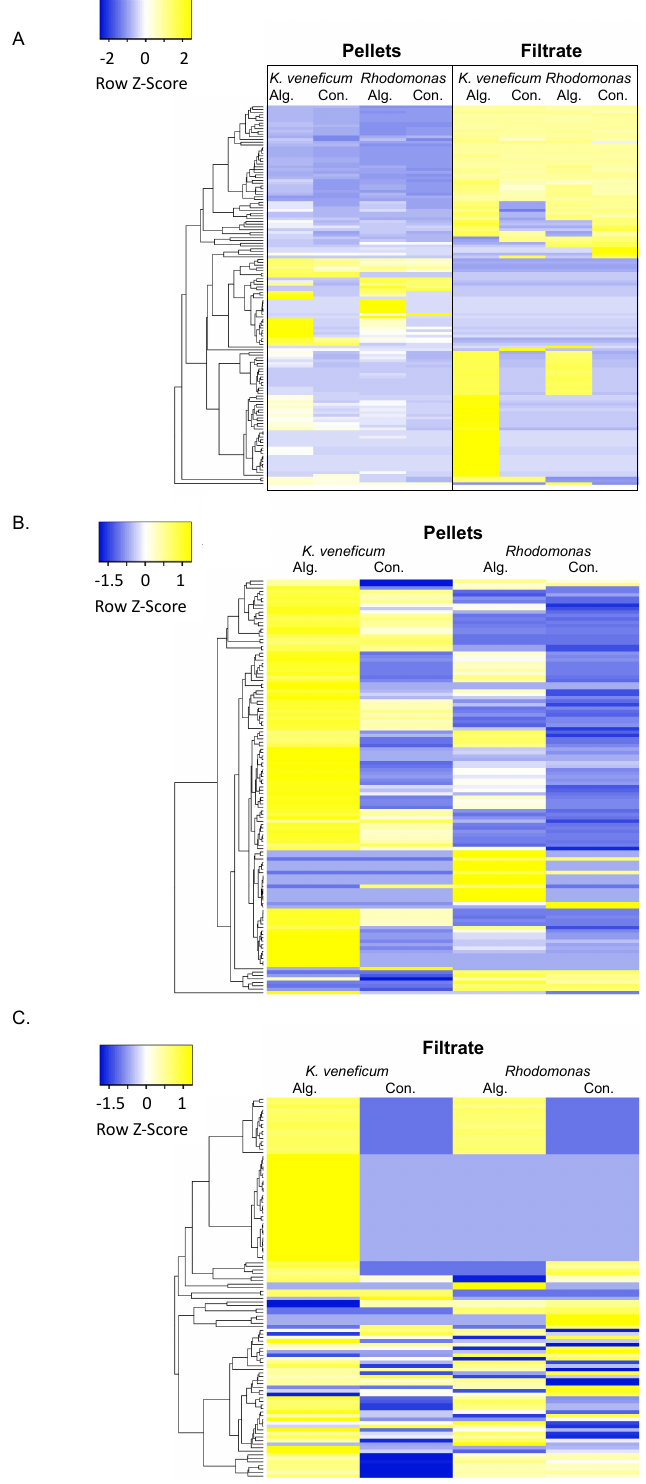
Figure 2. Heatmaps of the annotated compounds in the cell pellets and filtrate of Karlodinium veneficum and Rhodomonas treated with the algicide (Alg.) compared to the control (Con.; with no algicide addition). All annotated compounds were included in the heatmap. ( A ) Heatmap of all annotated compounds; ( B ) heatmap of compounds identified in the cell pellets; ( C ) heatmap of the compounds identified in the cell filtrate. Relative concentrations of each compound (RC) were log10 (RC+1) transformed first, and the row z-scores represent the normalized log10 (RC+1) across each row. The heatmap was created using Heatmapper [35].